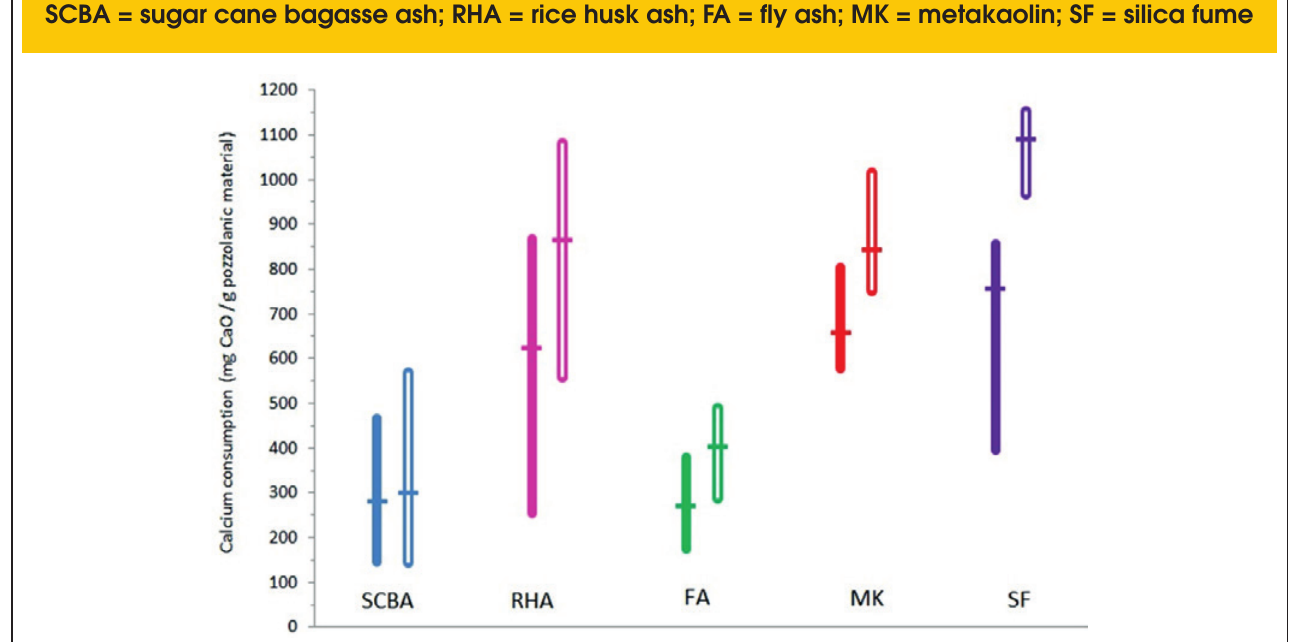
Figure 2 – Calcium consumption (g of CaO/g of vitreous of materials) of different pozzolanic materials. Tests were carried out with 1g (solid lines) or 2g (hollow lines) of CaO. Vertical lines represent the scattering of the results; mean values are shown as horizontal